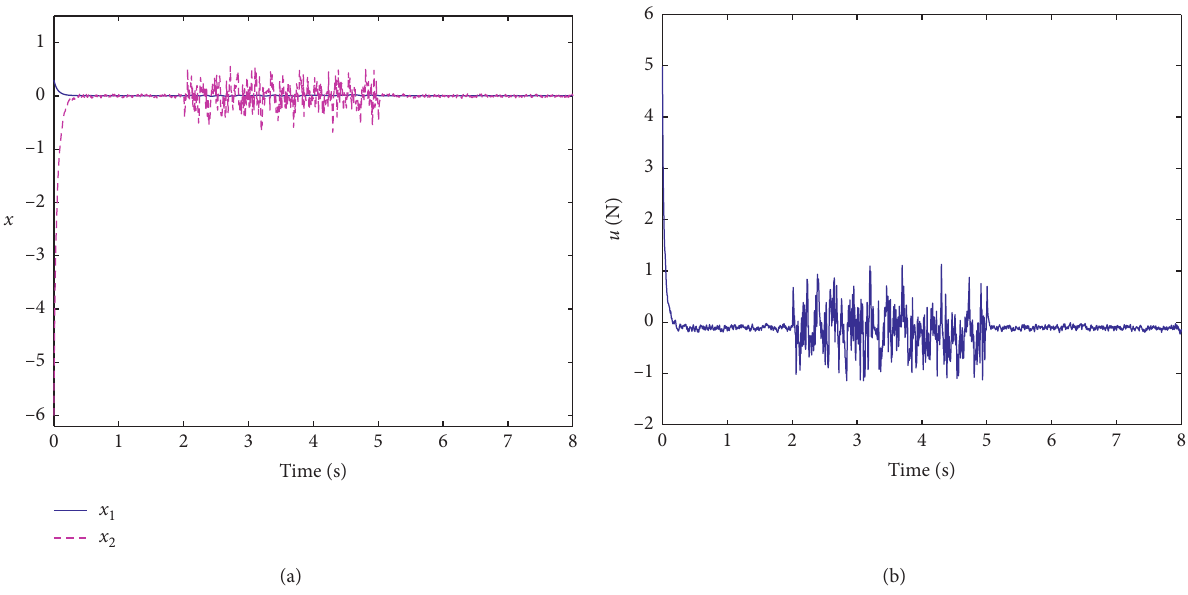
Figure 7: Evolution of the two states x the saturation level u